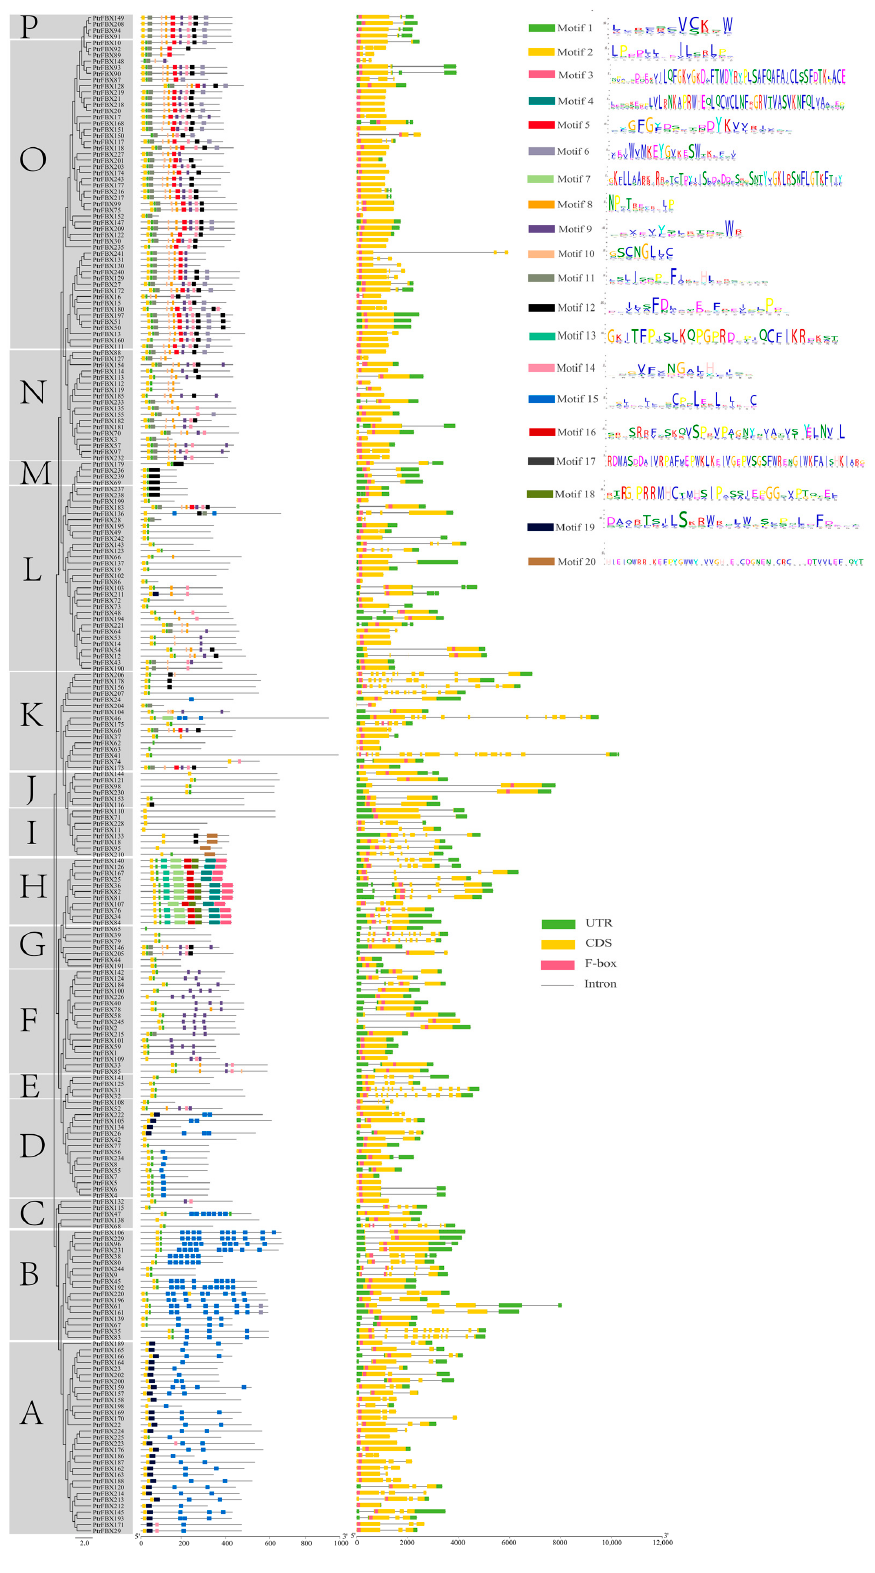
Figure 3. Structure and motif analysis of PtrFBX proteins. The subgroups (A–P) and motif analysis are on the left. The clustering is displayed according to the results of phylogenetic tree. Different colored boxes represent different motifs. The motif sequences are on the right. Gene structures are in the middle, where the green boxes represent untranslated regions, the yellow boxes represent exons and the grey lines represent intron